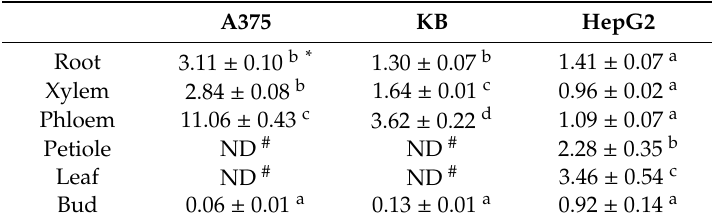
Table 2. The half maximal effective concentration (EC 50 value) of soluble free fractions of different vegetative parts from Boehmeria nivea L.